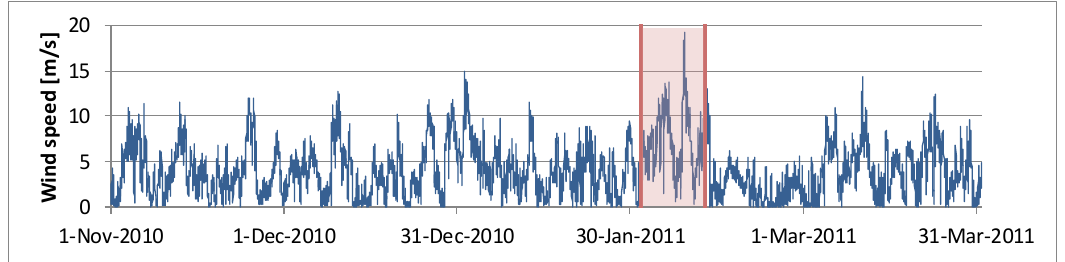
Figure 4. Air Temperature, precipitation and snow cover thickness measured at Frombork meteorological station in the winter season 2010/2011; the pink rectangle indicates the calibration period (1 February – 12 February); data from https://dane.imgw.pl/.